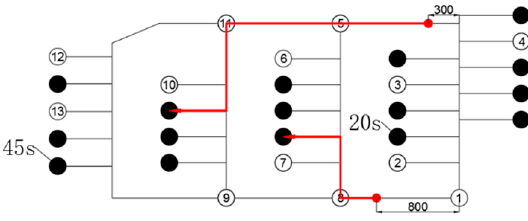
Figure 9. Real-time condition 1 of the parking lot.